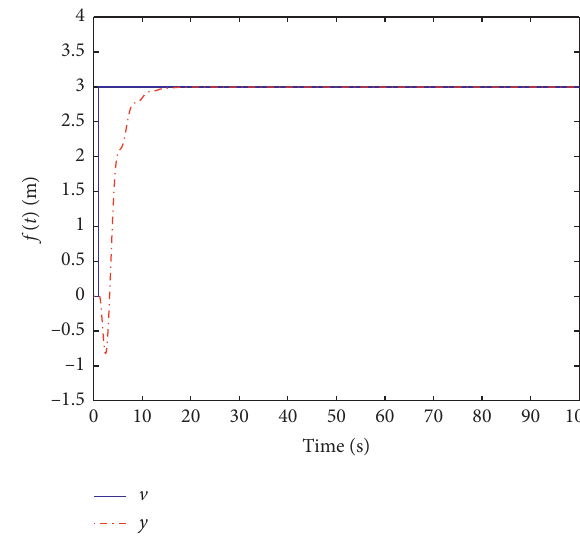
Figure 12: Control system response of 3( t ).